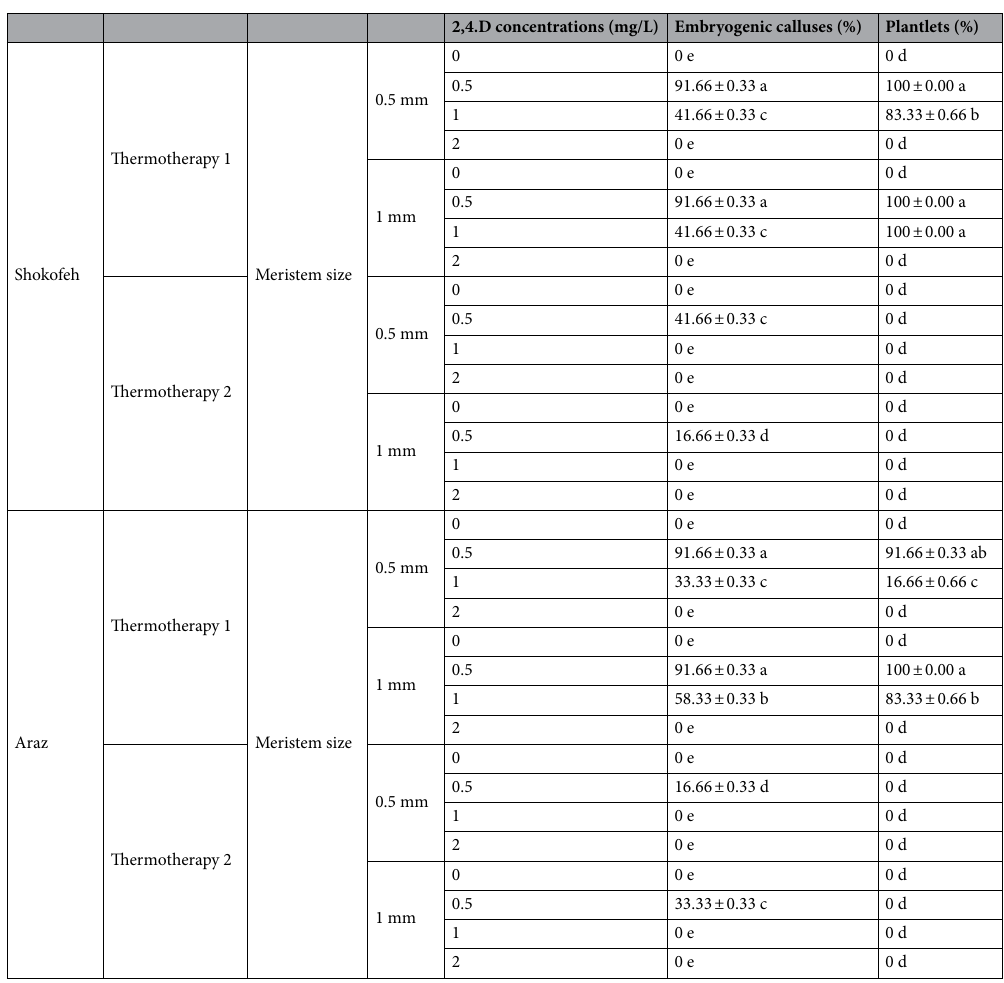
Table 6. Interaction effects of 2 cultivars, meristems sizes and thermotherapy treatments on the percentage of embryogenic calluses and plantlets (n = 3, p < 0.01, ±